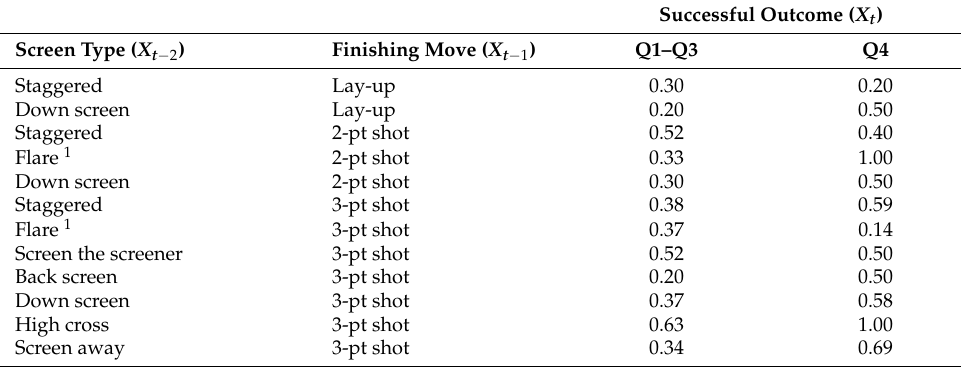
Table 7. Comparison of the probability estimates between finishing moves and screens to successful outcomes in the first three vs. last quarter.